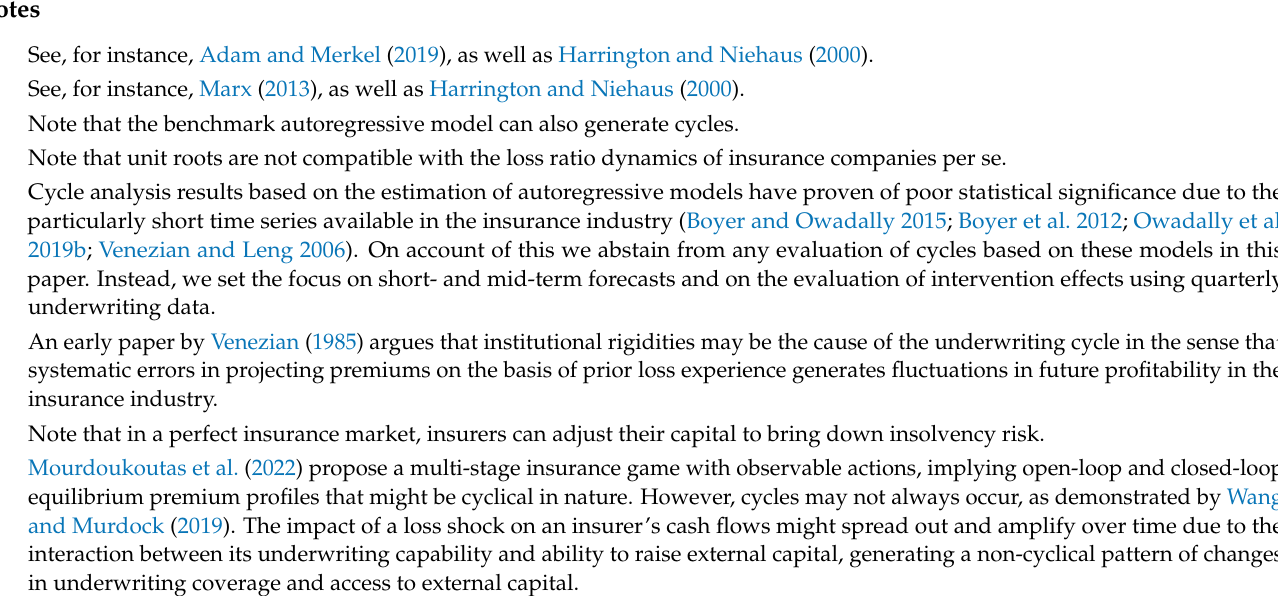
Figure A3. Autocorrelation functions (ACF) and partial autocorrelation functions (PACF) for the seasonally differenced loss ratios for four insurance companies: ( a ) Protective, ( b ) Cincinnati, ( c ) Pro- gressive and ( d ) State Auto. Note: All series have been logarithmically transformed